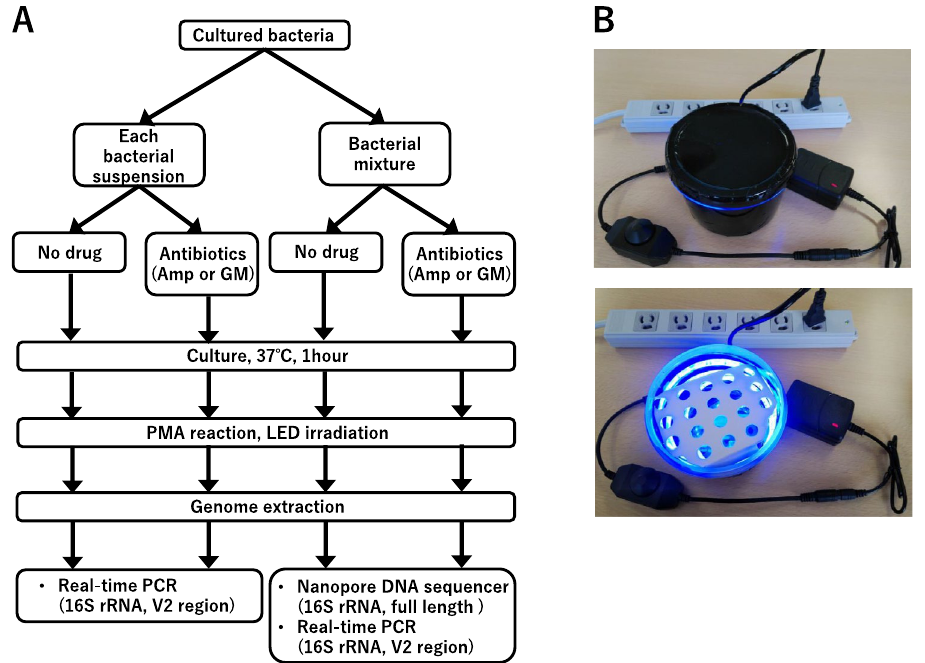
Figure 2. Study design and LED irradiator. ( A ) Study design. ( B ) a handmade blue LED irradiator with 60 SMD6060 chips. Top: setup; bottom: when turned